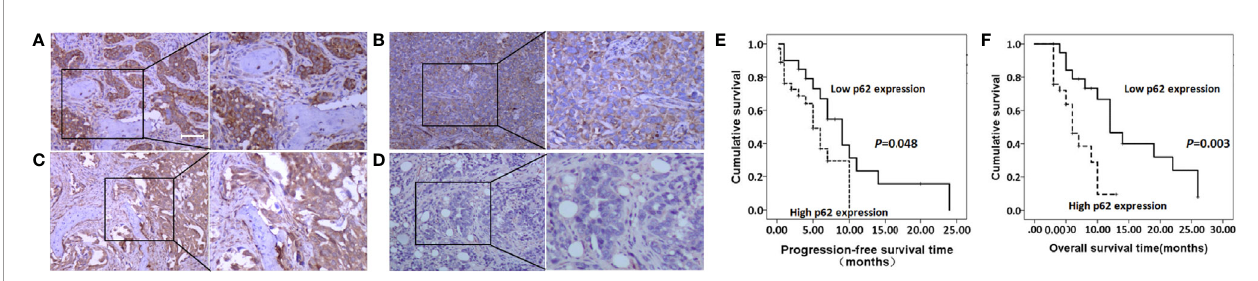
FIGURE 2 | p62 and LC3B protein expression as determined by immunohistochemistry assay. (A, B) High p62 (A, scale bar 100µm) and LC3B (B) expression at magni fi cation ×100 (left) and ×200 (right). (C, D) Low p62 (C) and LC3B (D) expression at magni fi cation ×100 (left) and ×200 (right). (E, F) High p62 expression was associated with shorter progression-free survival rates (E) and overall survival rates (F) in patients with bone metastasis of lung adenocarcinoma.